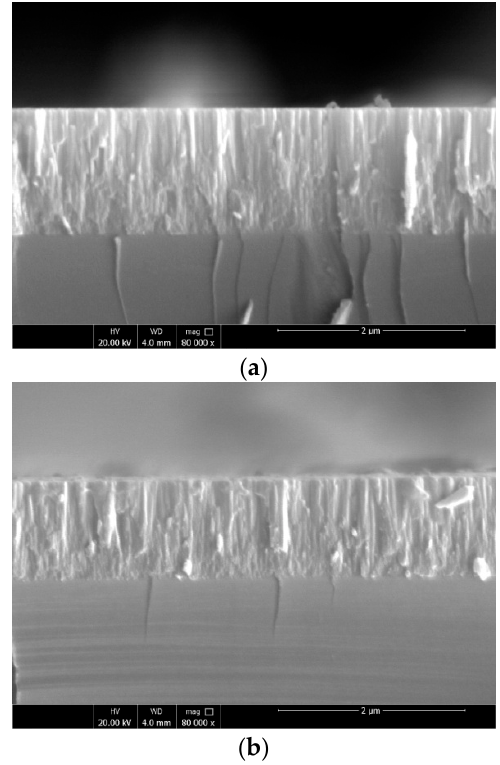
Figure 5. Cross-sectional morphology of a typical AlN:Er sample deposited ( a ) without substrate heating and ( b ) with substrate temperature maintained at 400 °C.